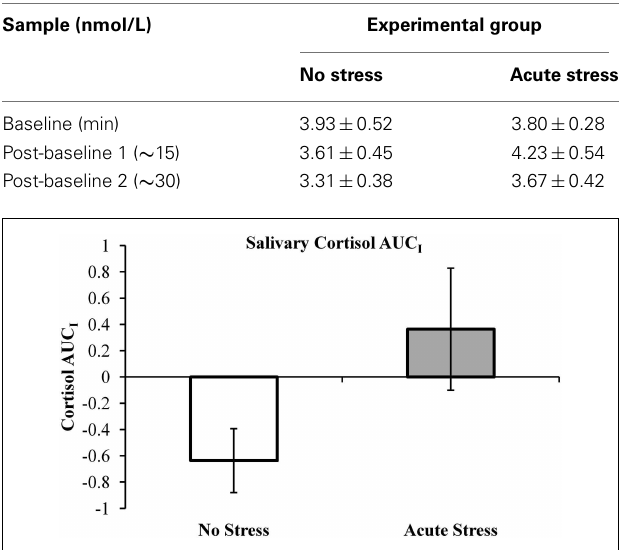
FIGURE 2 | Salivary cortisol area under the curve with respect to increase (AUC I ) by experimental group. Note, negative AUC I values (indicating a decrease in salivary cortisol over the course of the experiment) were retained as an “index of decrease” as recommended by Pruessner et al.